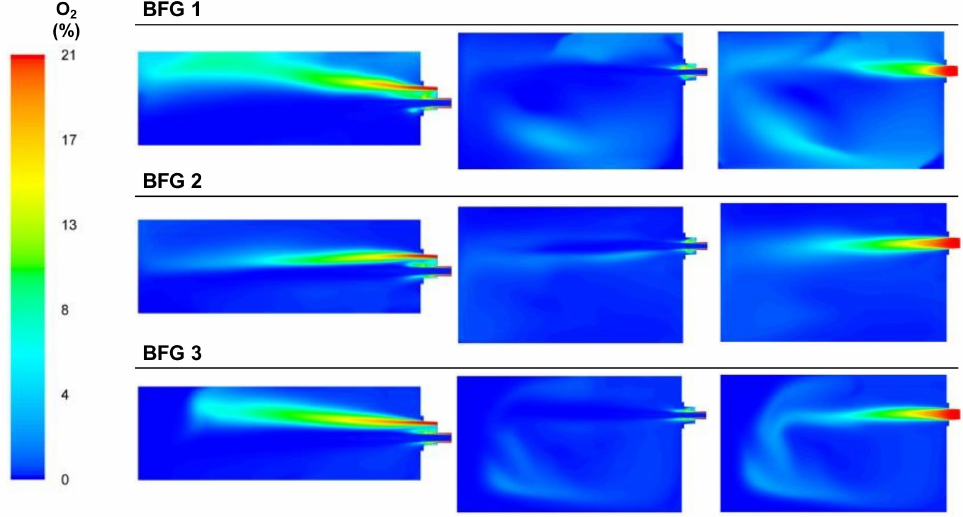
Figure 14. Contour plots of oxygen concentrations for the BFG cases in the XZ1, XY1, and XY2 planes. As shown in Figure 15, the NOx generation in the case of BFG was low since the temperature of the combustion was the lowest out of all the fuels, even though in the cases with air excess, there was oxygen available for nitrogen oxidation. The combustion temper- atures were similar for the three air-to-fuel ratio cases so all cases presented nearly the same generation of NOx. The areas with NOx rate generation can be observed. Thermal NOx production happened in areas with high temperatures and enough oxygen concentration, and this can be observed in the contours of the NOx rate, oxygen, and